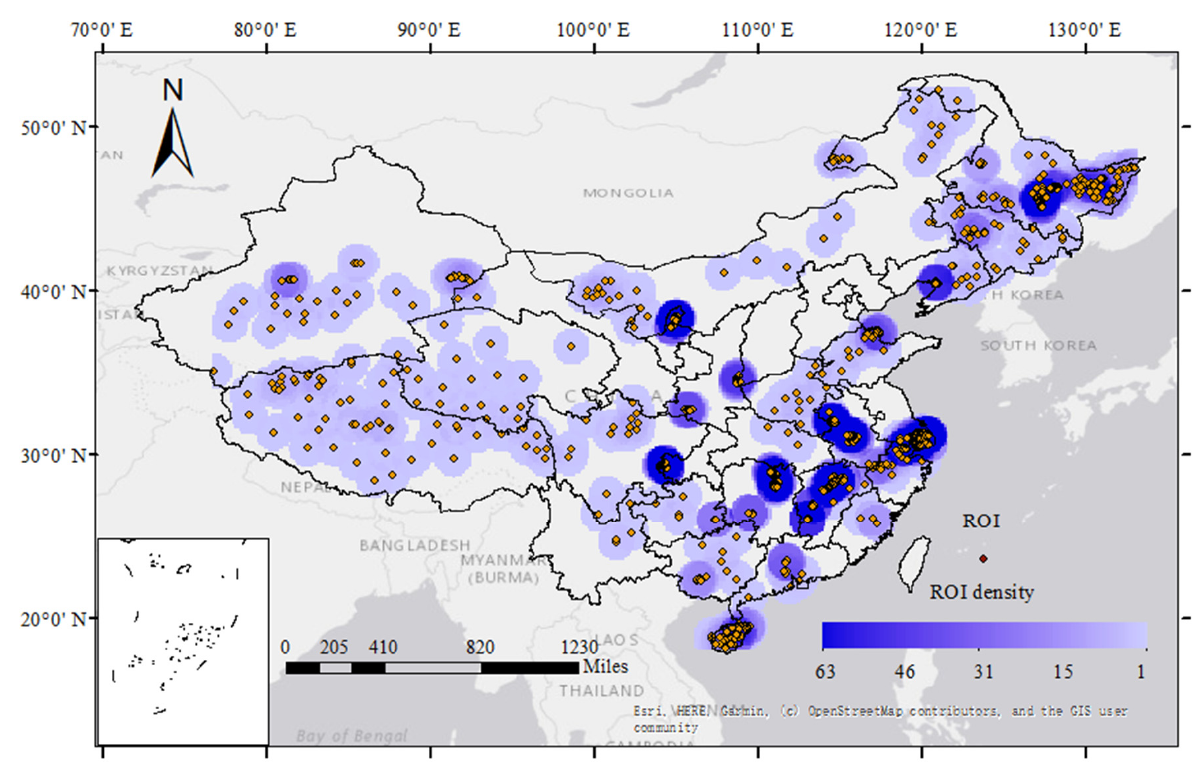
Figure 3. The region of interest (ROI) distribution in China. The base map is from the GIS user community (https://www.esri.com/en-us/home) (accessed on 10 November 2021).